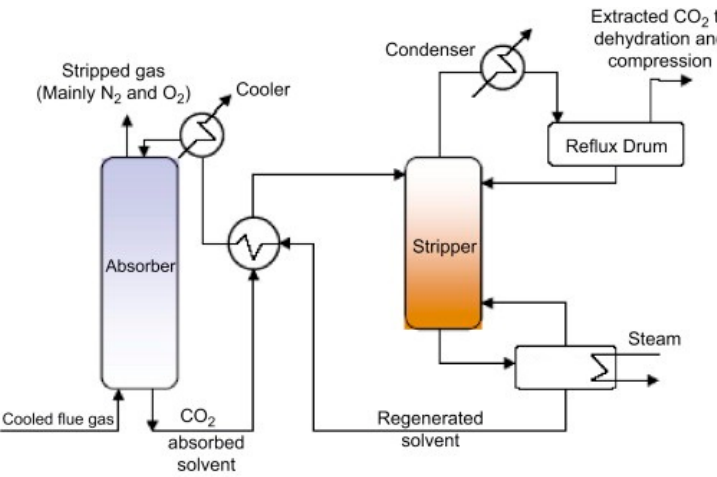
Figure 7. Schematic diagram of a CO 2 absorption plant [51].